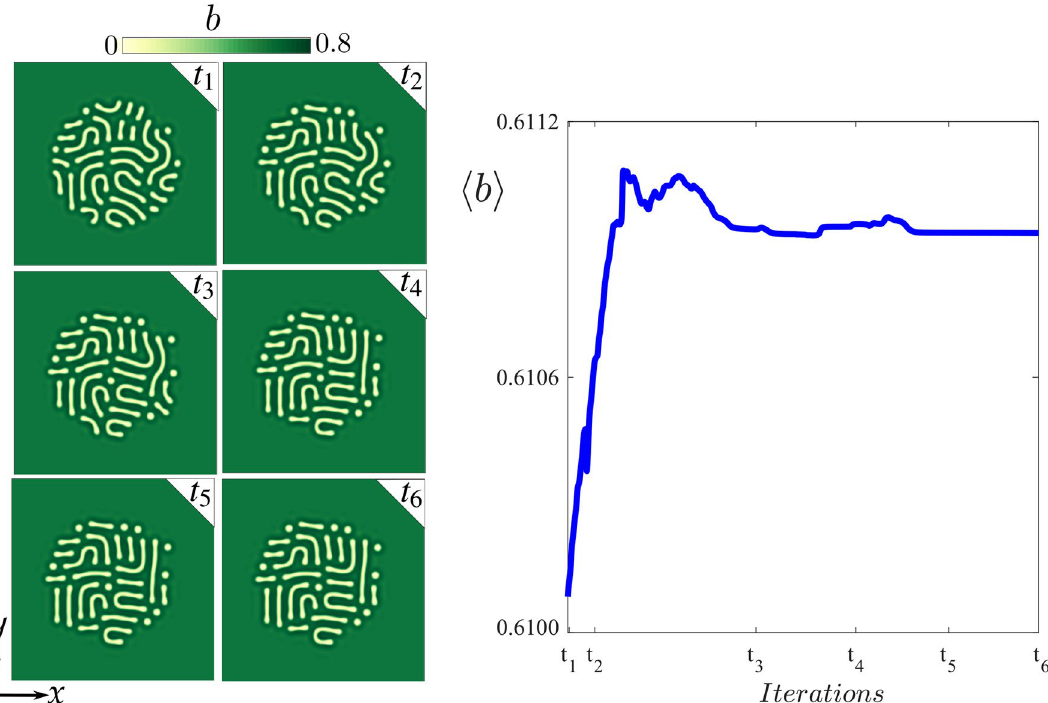
Figure 7. Initialization and stabilization of localised labyrinthine pattern in the integrodifferential model Eq. (2). The aridity parameter is µ = 1.3 . The other parameters are summarized in Table 3 on "Methods" section. The sequence t 1 = 1 to t 6 = 4 · 10 5 accounts for the evolution towards equilibrium of the localised labyrinthine pattern, starting from a circular patch of a labyrinth state embedded in a vegetated background ( t 1 ). The curve in the right shows the evolution of the average biomass density (cid:31) b (cid:30) , that is the double integral of the two dimensional biomass field b divided by the area of the simulation box (see the Integrodifferential model subsection). The stable labyrinthine pattern is reached in t 5 ≈ 10 5 iterations of the RK4 time integrator, when there is no change in (cid:31) b (cid:30) . From numerical simulations, the figure was created using Inkscape 1.0 (https:// inksc ape. org/ relea se/ inksc ape-1.